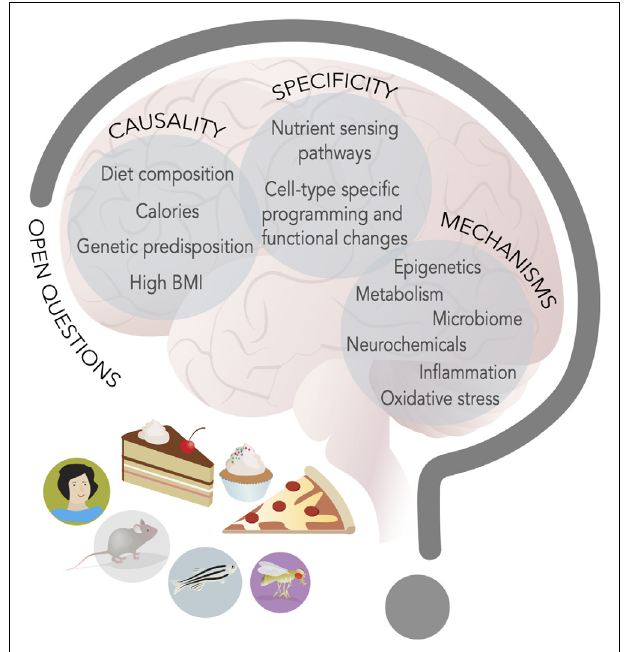
FIGURE 3 | New food for thought. Research in model organisms and humans has advanced our knowledge of the interplay between energy-dense diets and behavior, but at least three main questions remain open (capital letters); hints to possible mechanisms (listed inside circles) have emerged and studies on these topics will define the next decade of research in the neuroscience of nutrition